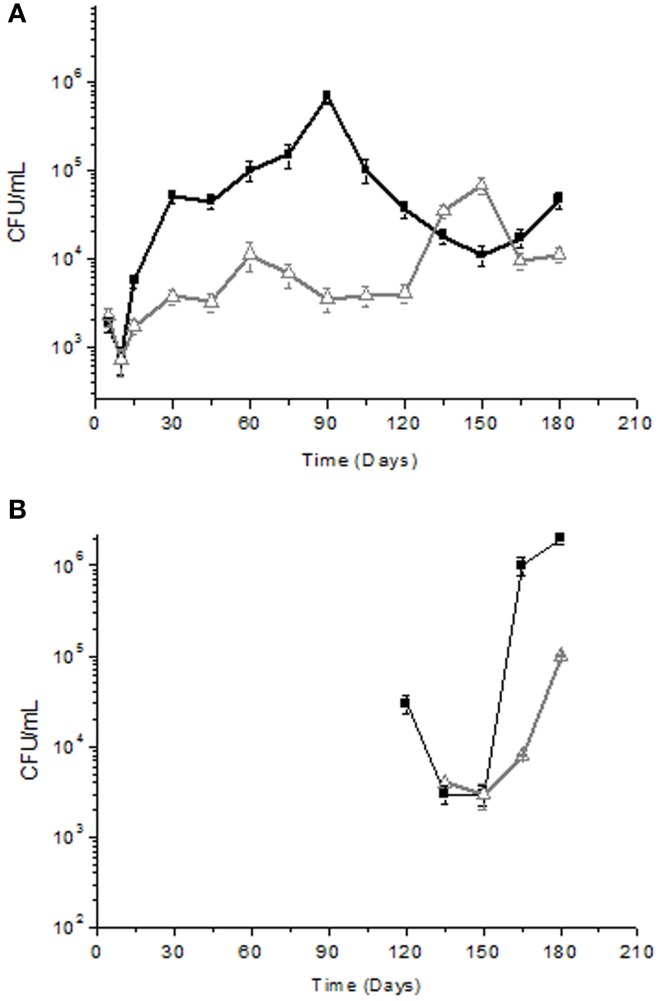
Yeast (A) and LAB (B) total counts (Log CFU/ml) of Cellina di Nardò

and Leccino

naturally fermented table olives. Detection limit ± 10 cfu/ml. LAB were not detected during the period of time between 15 and 120 days of fermentation.